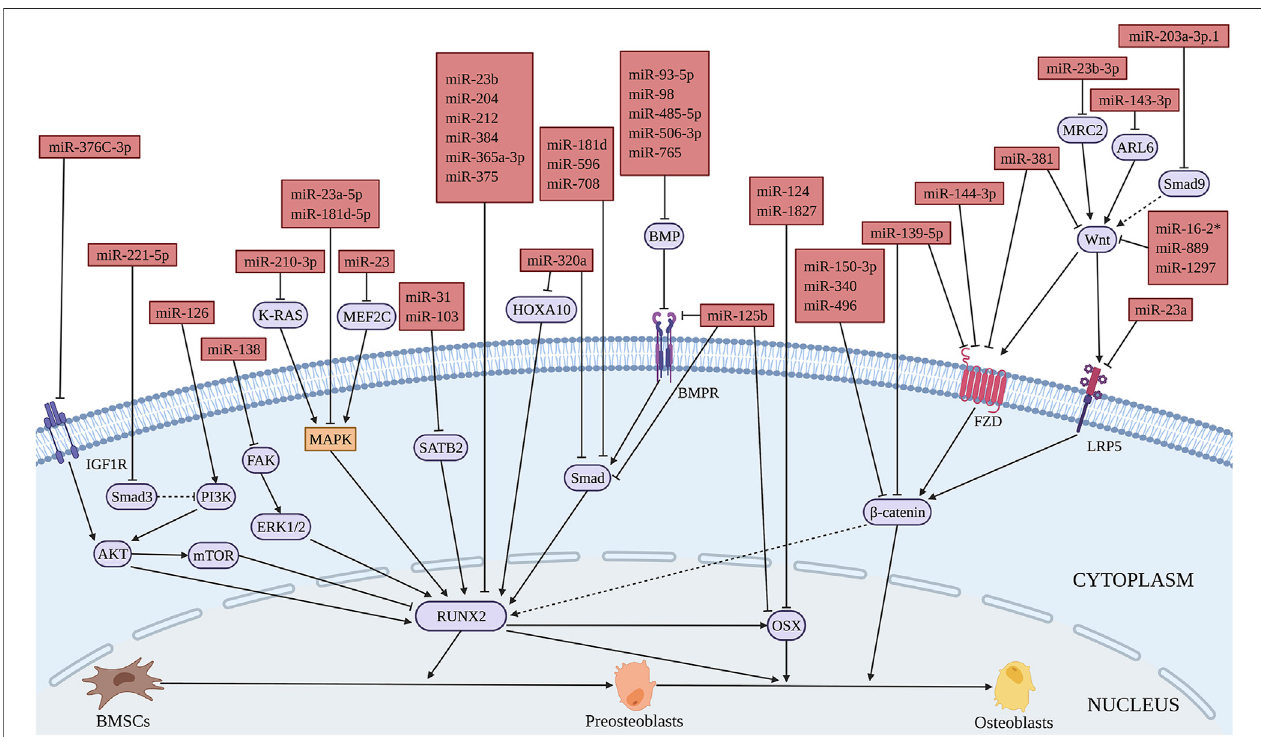
FIGURE 3 | Illustration of the role and regulatory mechanism of miRNAs-inhibited osteogenic differentiation of BMSCs. (Created with BioRender.com).